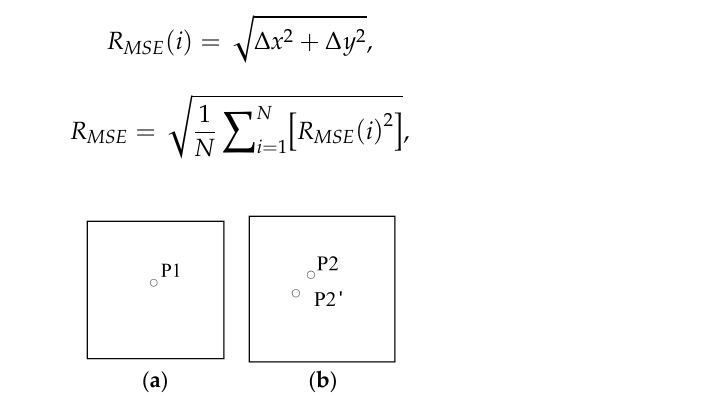
Figure 5. Schematic diagram of the adjustment for matching points. ( a ) Reference band. ( b ) Band to be registered.